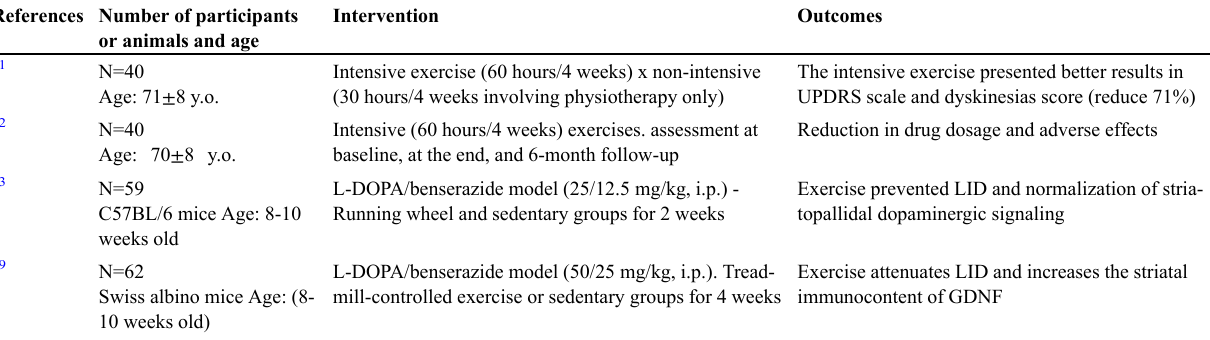
GDNF: cell-derived neurotrophic factor; LID: L-DOPA-induced dyskinesia; i.p: intraperitoneal; y.o.: Years